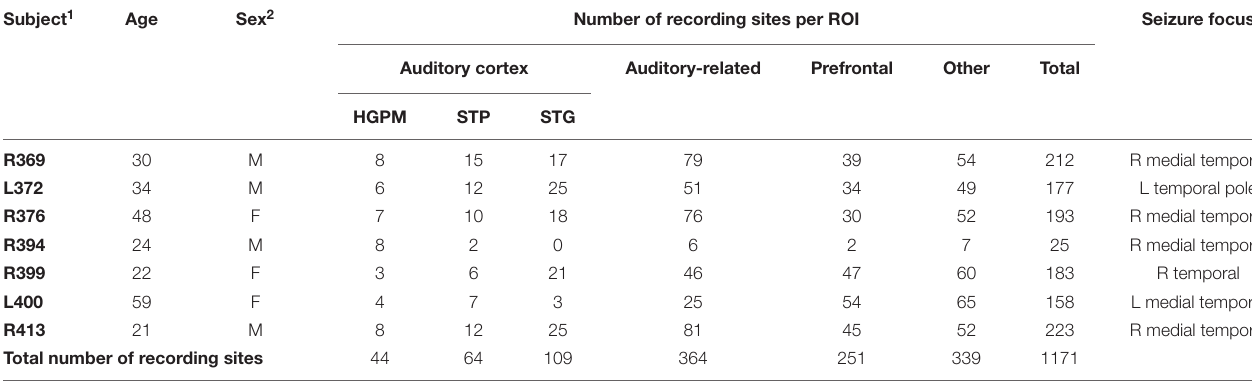
TABLE 1 | Subject demographics and electrode